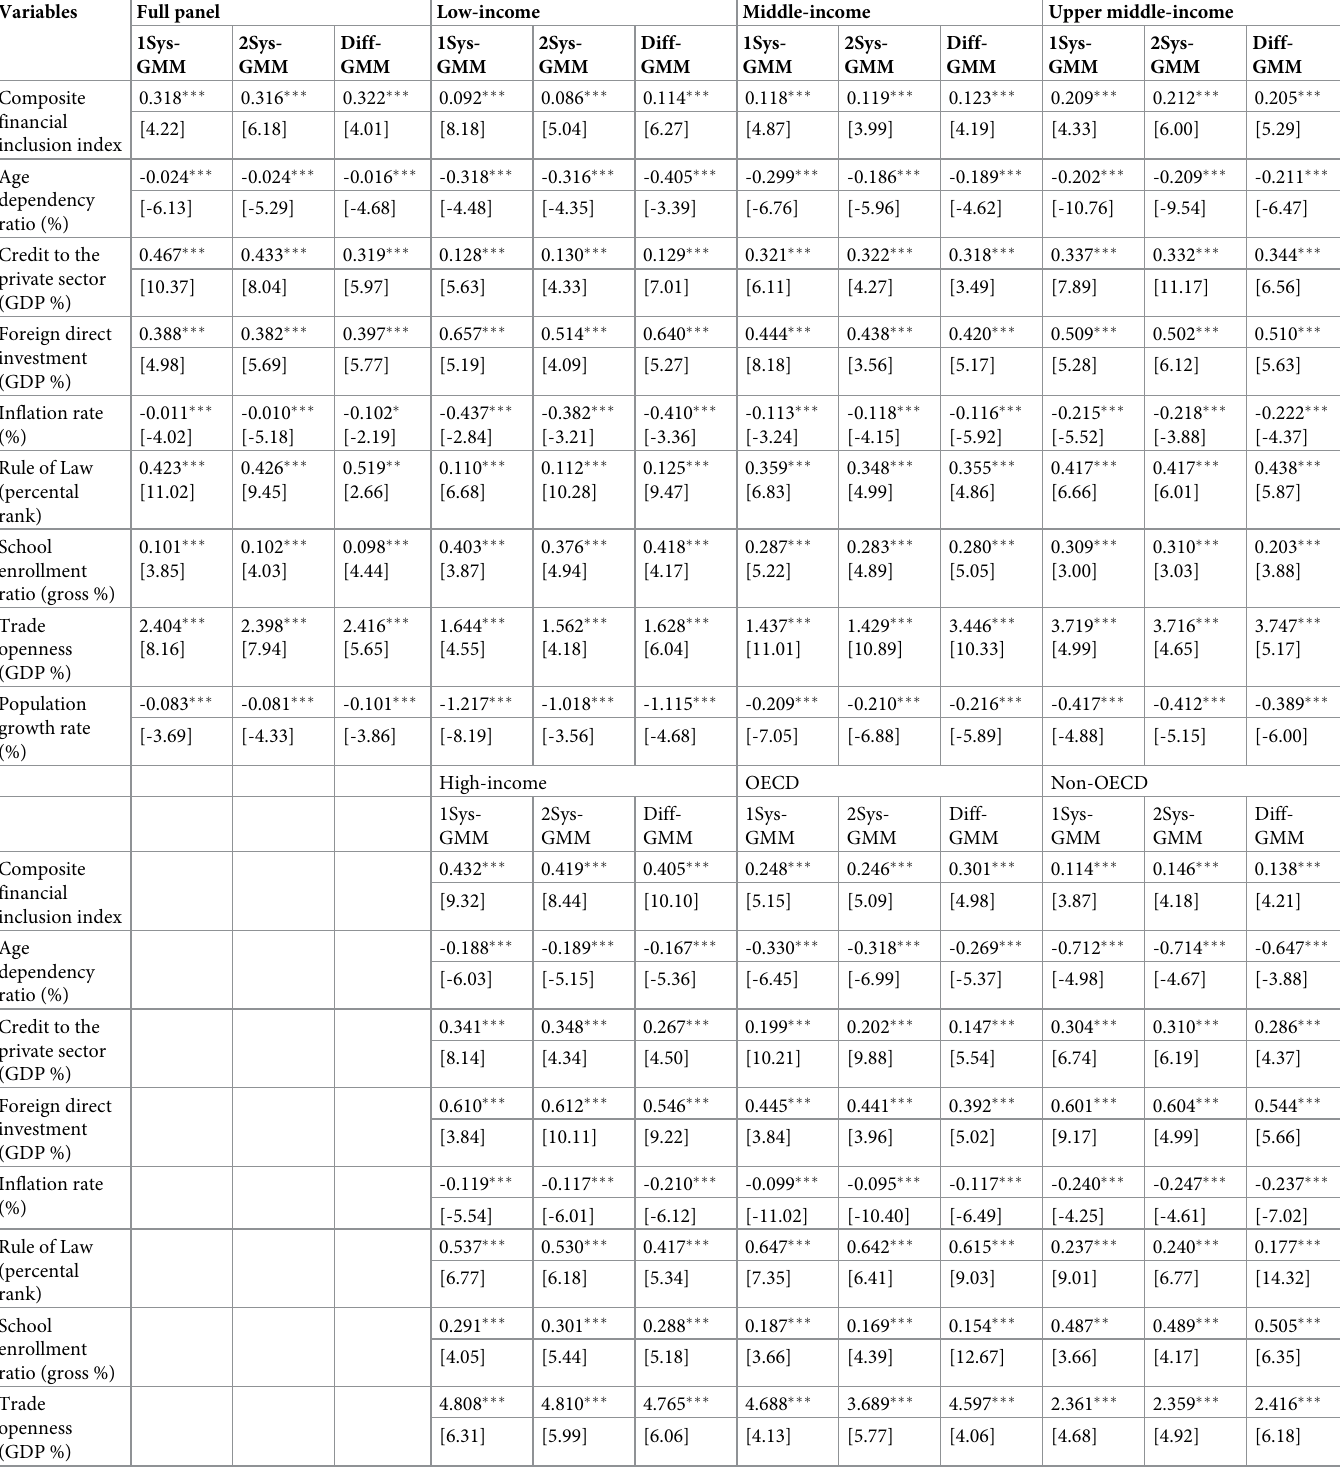
Table 3. Results of the GMM estimates for income level economies.